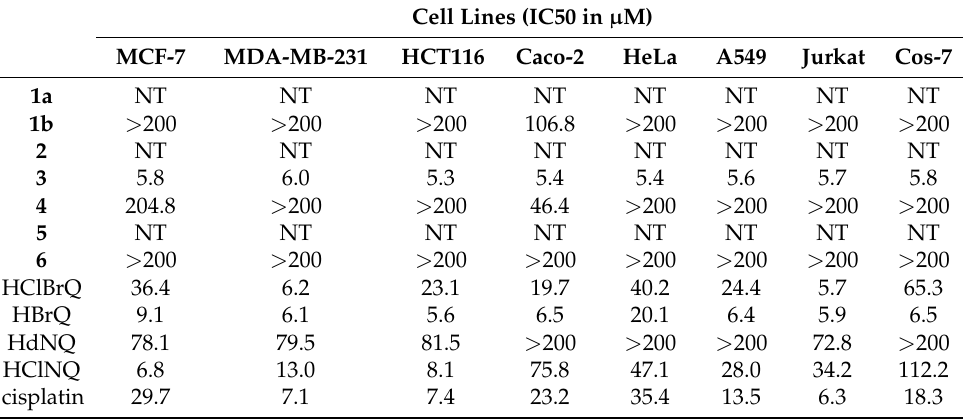
Table 3. IC 50 values of tested copper(II) complexes and their ligands.